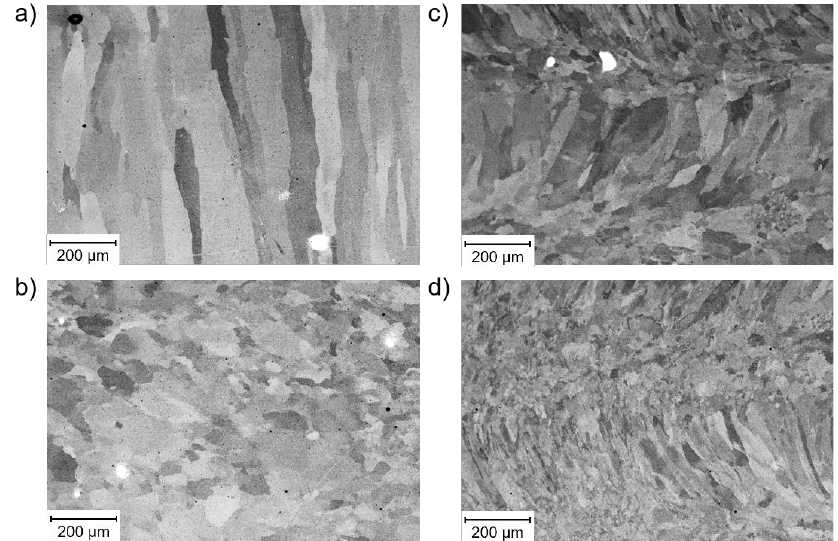
Figure 15. Comparison of as-built and post-compression creep experiment microstructures (speci- mens taken longitudinally to build direction). LPD: ( a ) as-built and ( b ) after compression creep. HPD: ( c ) as-built and ( d ) after compression creep.